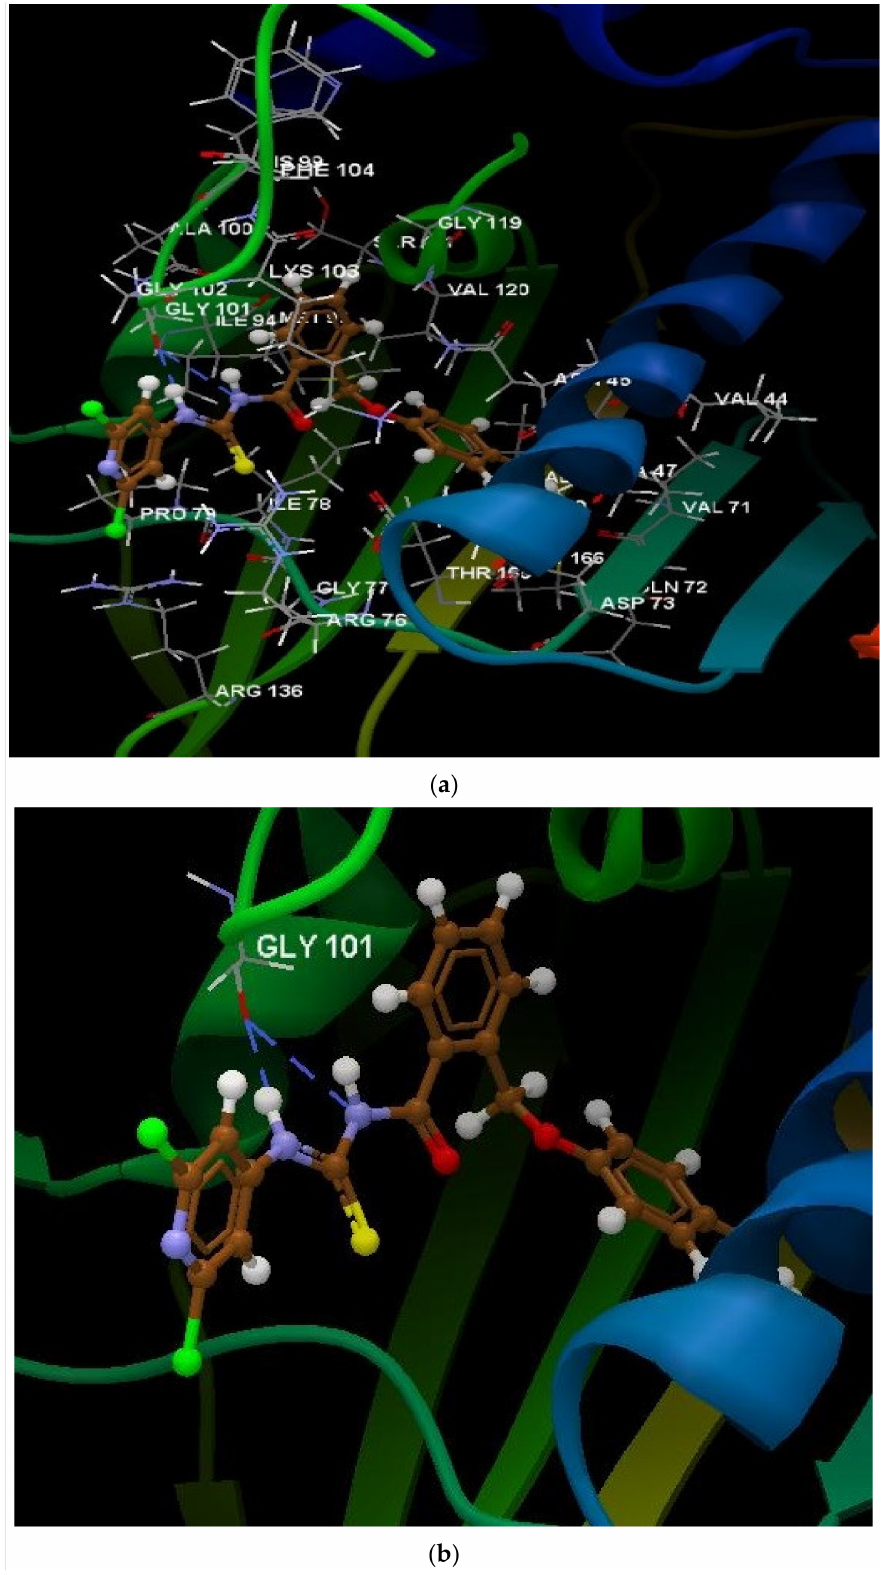
Figure 10. ( a ) The interaction group for the ligand 1n. ( b ) Hydrogen bonds created between the ligand 1n and the amino acid GLY